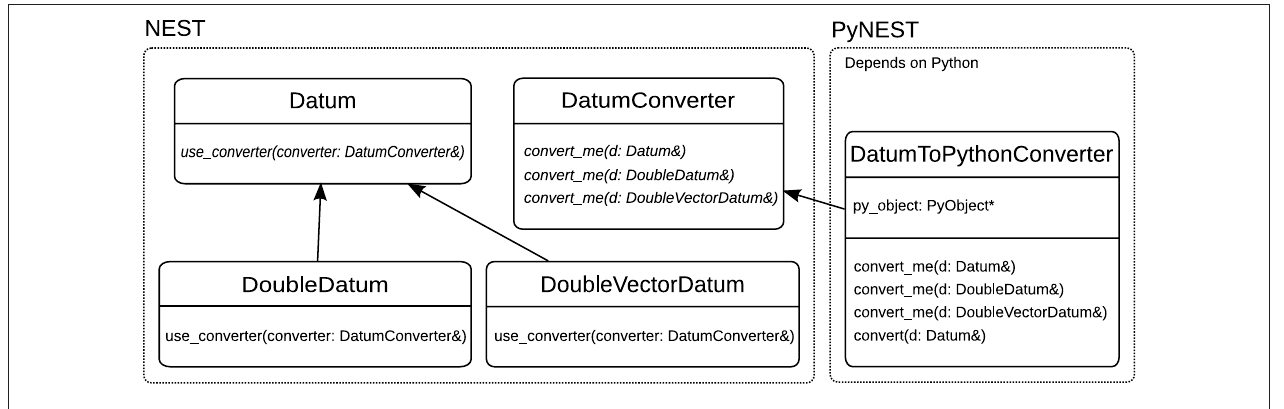
FIGURE 3 | Class diagram for the acyclic visitor pattern used to convert SLI types to Python types. The left rectangle contains classes belonging to NEST, the right rectangle contains classes that are part of PyNEST. All SLI data types are derived from the base class Datum and inherit its